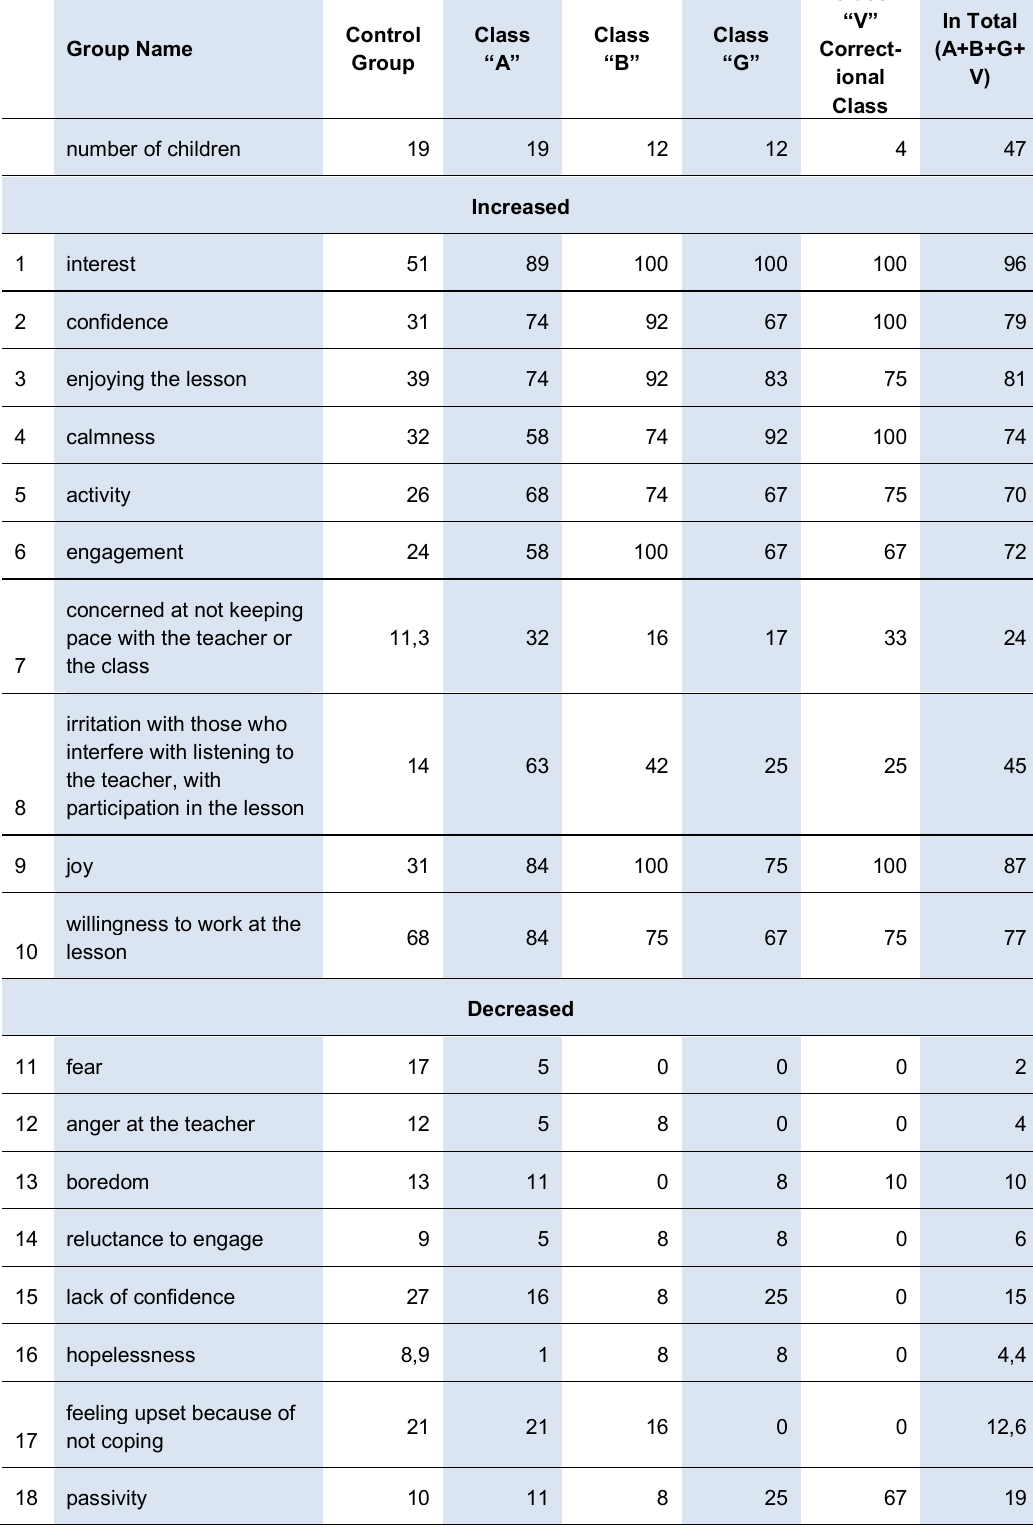
Table 4: Data for the sub-groups of the educational